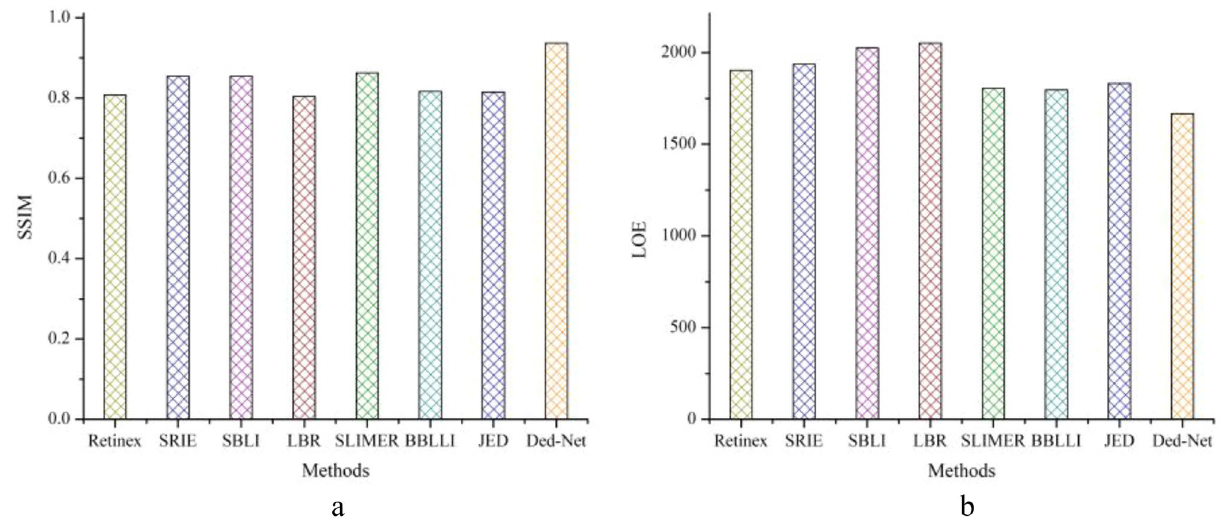
Figure 14. Comparison in terms of ( a ) SSIM and ( b ) LOE evaluation metrics with several sate of the art